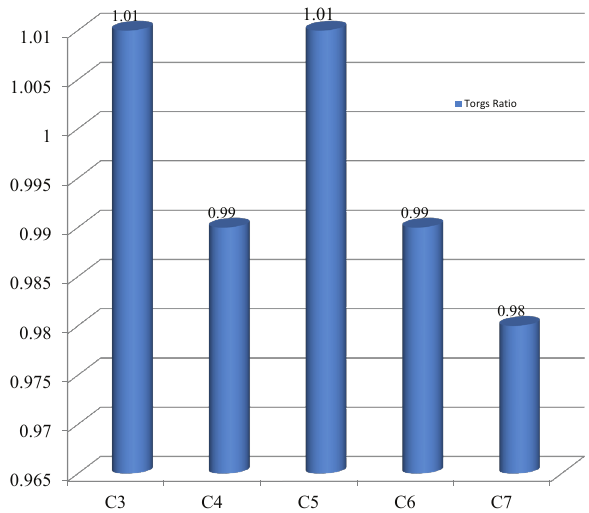
Figure 2: The mean Torg’s ratio of different vertebral level The mean Torg’s ratio were equal in male and female at vertebral level C3, C4, C5 and C6 except for C7 where the Torg’s ratio in female was higher than male (p-value